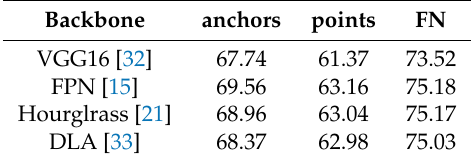
Table 4. Comparisons with different backbones on DOTA